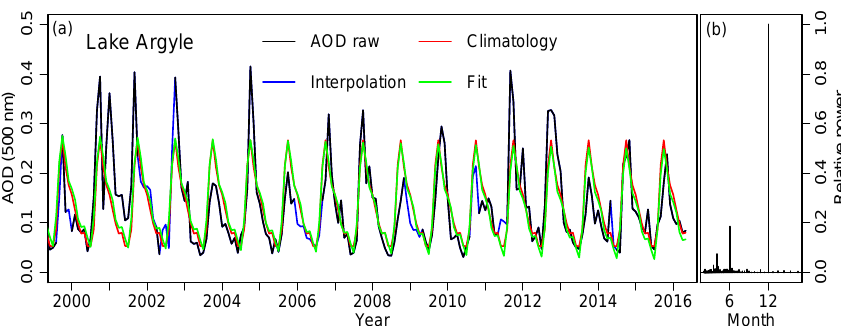
Figure 2. (a) Time series of monthly mean aerosol optical depth at 500nm at Lake Argyle. The raw data are shown in black, the (repeated) climatology in red, the interpolated data in blue (see text), and the model fit in green. (b) The power spectrum of the interpolated time series computed using a fast Fourier transform (FFT).